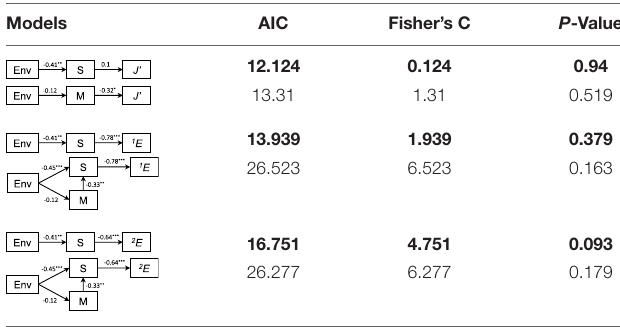
TABLE 1 | Best path models to explain the effect of environmental seasonality, species richness, and average biomass on community evenness.